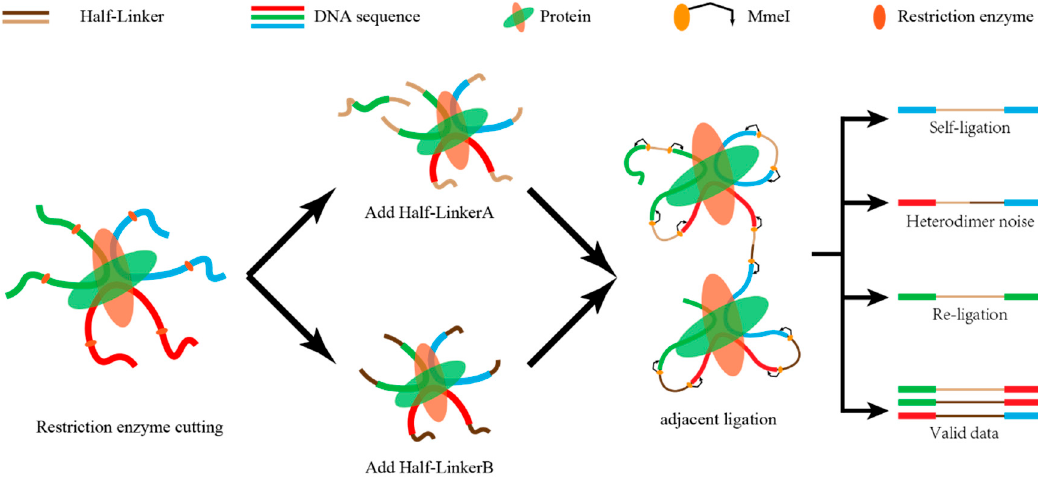
Figure 4. A sketch map of self-ligation and re-ligation. The fragments of interacting DNA pairs are divided into four categories—self-ligation, heterodimer noise, re-ligation, and valid data. Only the valid data are kept for further analysis.